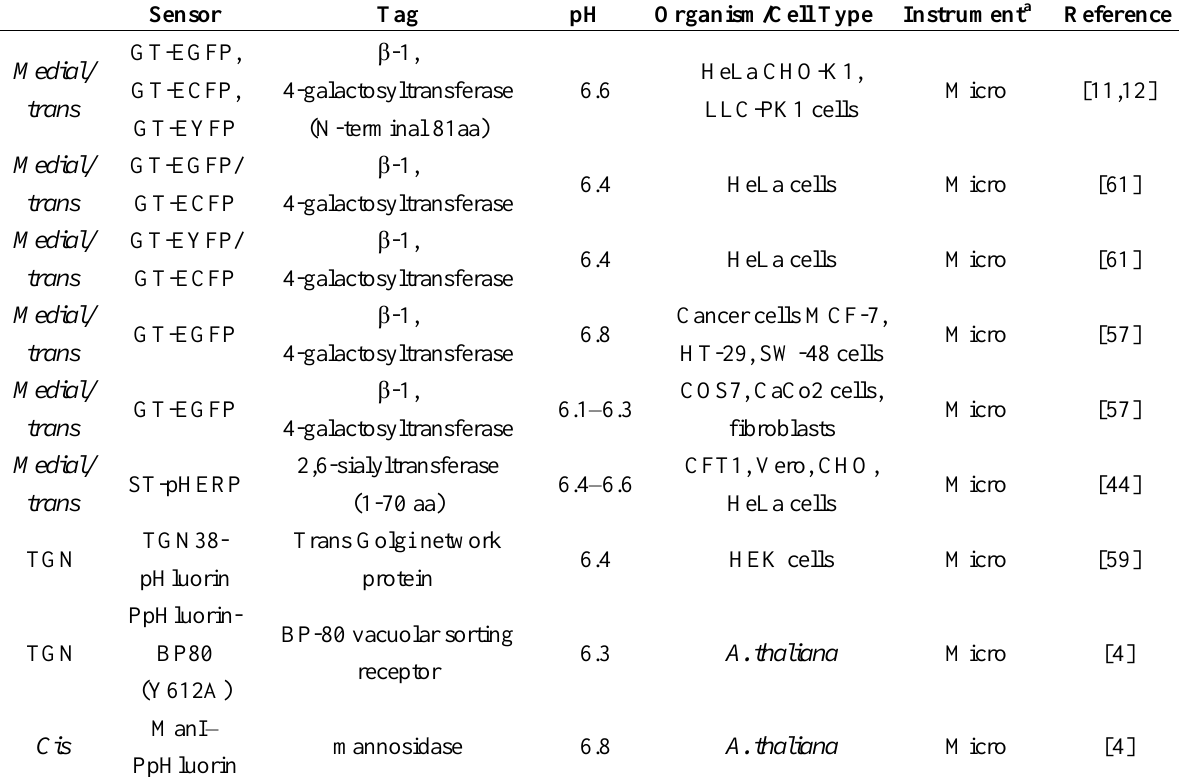
Table 5. Select examples of pH-sensitive FPs targeted to